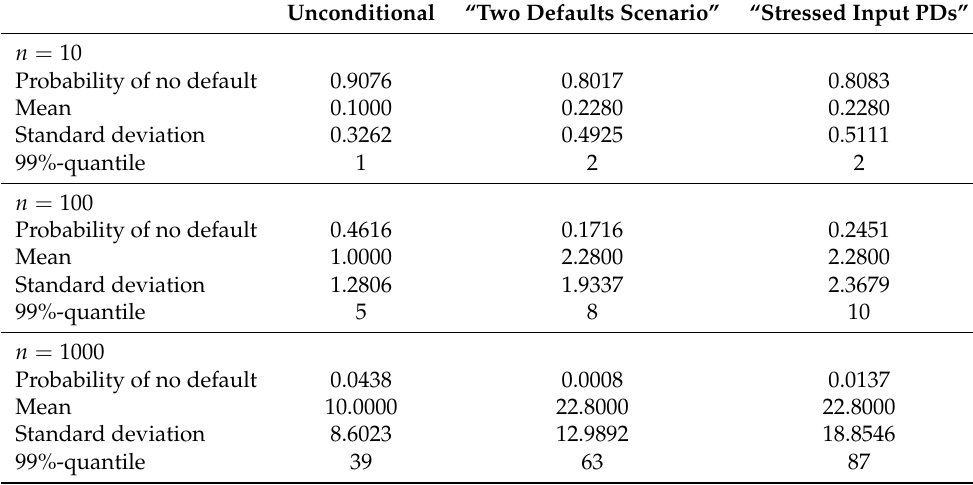
Table 1. Characteristics of unconditional, conditional on two defaults and “stressed input probabilities of default (PDs)” distributions of numbers of defaults in portfolios of n = 10, n = 100 and n = 1000 obligors. All obligors have unconditional PD 1%. The model is one-factor CreditRisk + with factor standard deviation